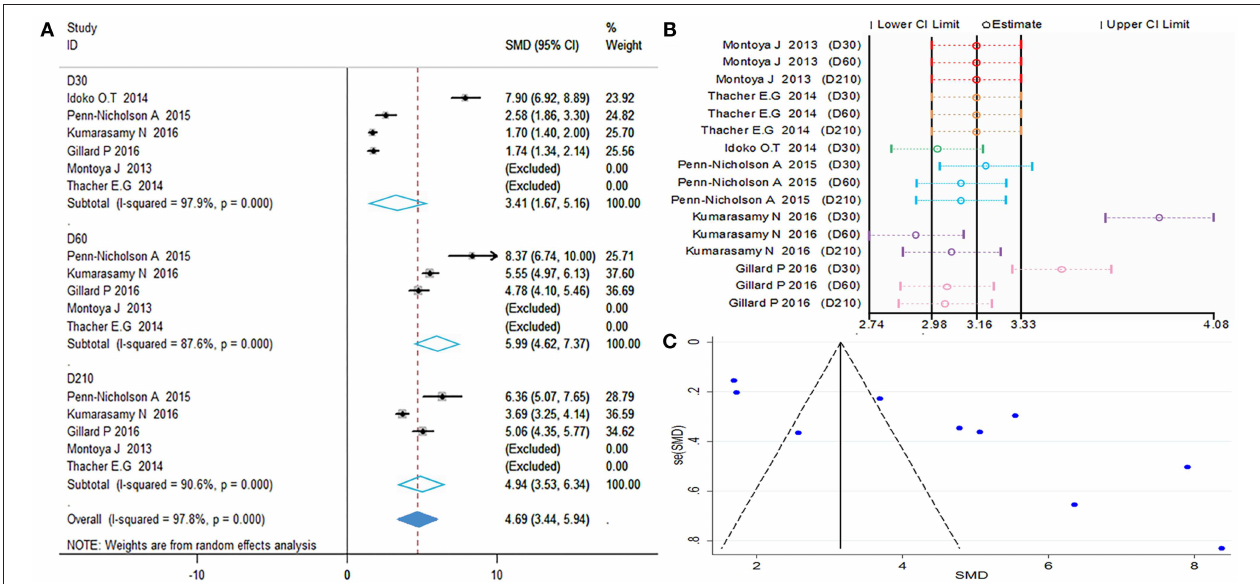
FIGURE 5 | Anti-M72 IgG geometric mean concentration(GMC). (A) Forest plot: SMD > 0 indicates that the vaccine was protective. SMD = 0, invalid result. Point estimates and 95%CI are shown for each study and for the pooled results. (B) Influence analysis, examine the impact of a study on the total combined effect. The vertical solid line in the middle indicates the total combined effect, while the left and right vertical solid lines indicate 95%CI. (C) Funnel plot: the publication bias was independently assessed by determining the symmetrical distribution of the studies.